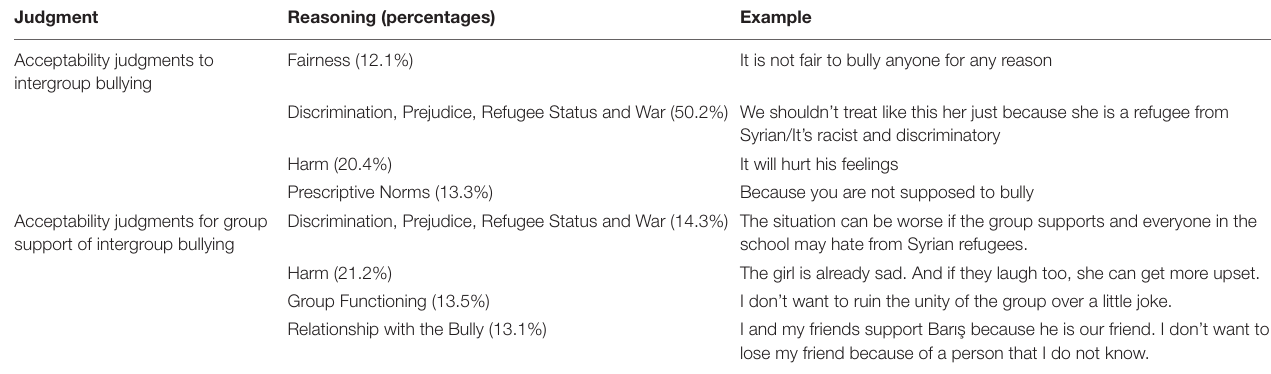
TABLE 1 | Examples and percentages of reasoning for acceptability judgments. Judgment